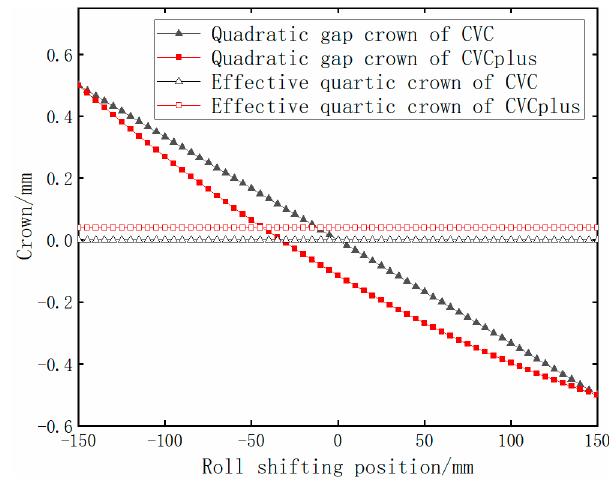
Figure 4. Quadratic gap crown and effective quartic crown of CVCplus.